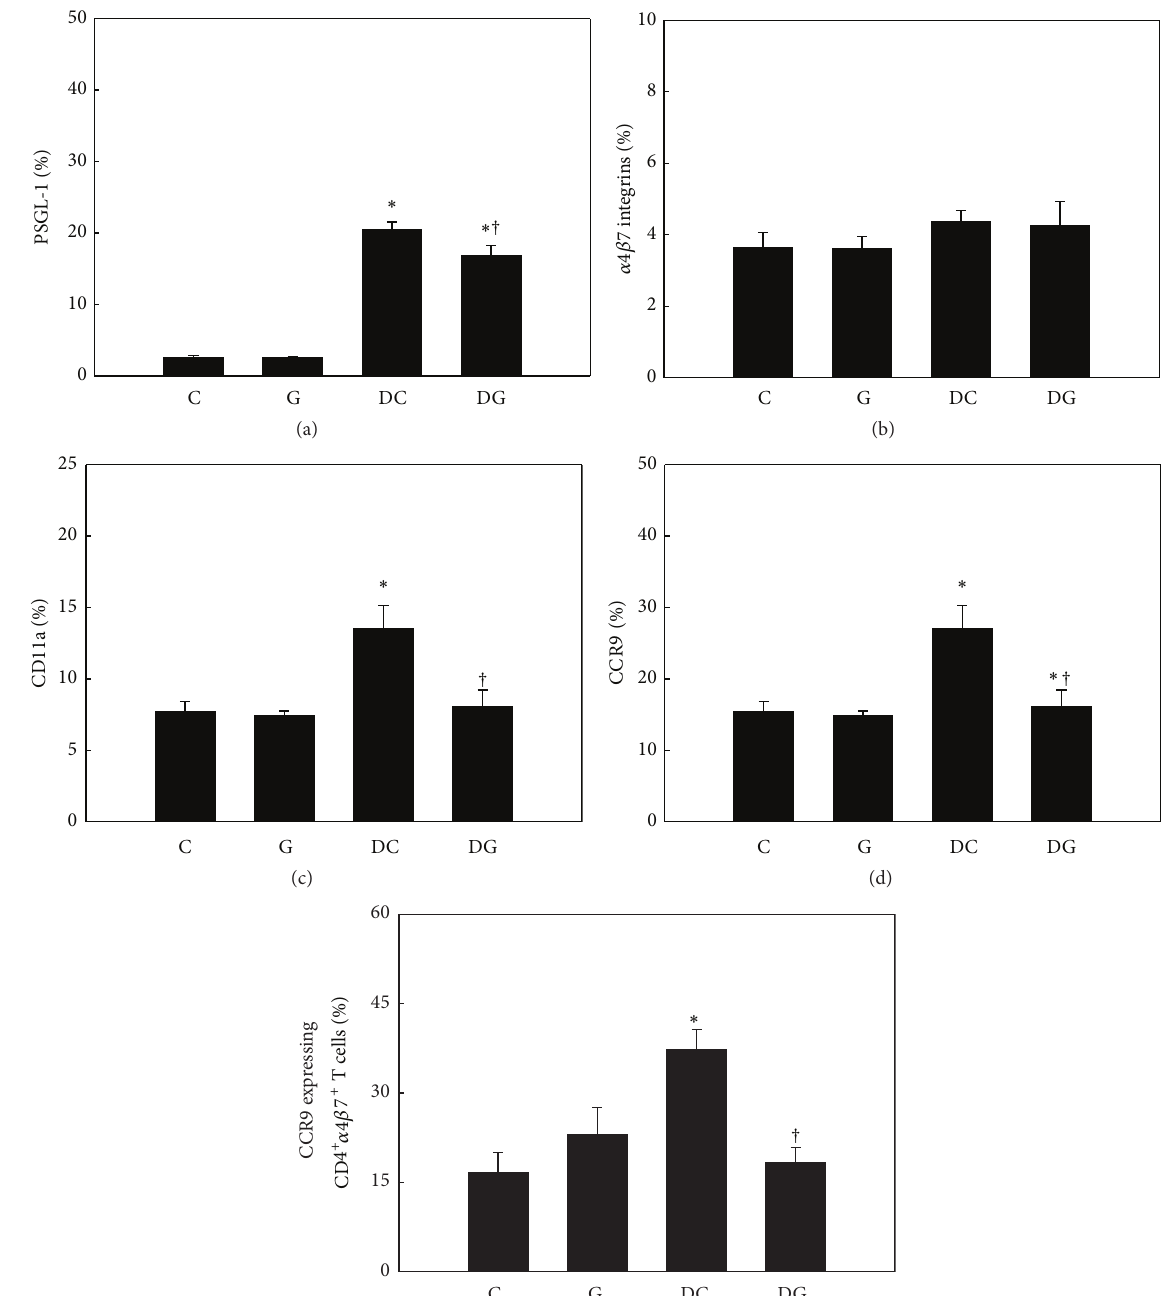
Figure4:Percentageofadhesionmolecule-andchemokinereceptor-expressingThelper(Th)cellsinblood.CD4-positivebloodlymphocytes were gated to analyze expressions of PSGL-1, 𝛼4𝛽7 integrins, CD11a, and CCR9 by flow cytometry ((a)–(d)). (e) Expression of CCR9 by CD4 and 𝛼4𝛽7 integrin double-positive blood lymphocytes. Values are shown as the mean ± SEM. ∗ Significantly different from the C group ( 𝑃 < 0.05 ). † Significantly different from the DC group ( 𝑃 < 0.05